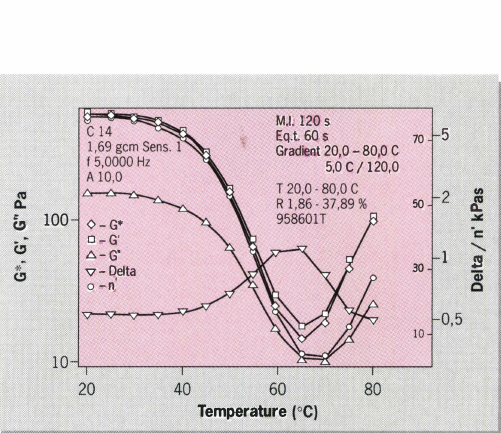
Fig. 4: Temperature-dependent behaviour of sample A